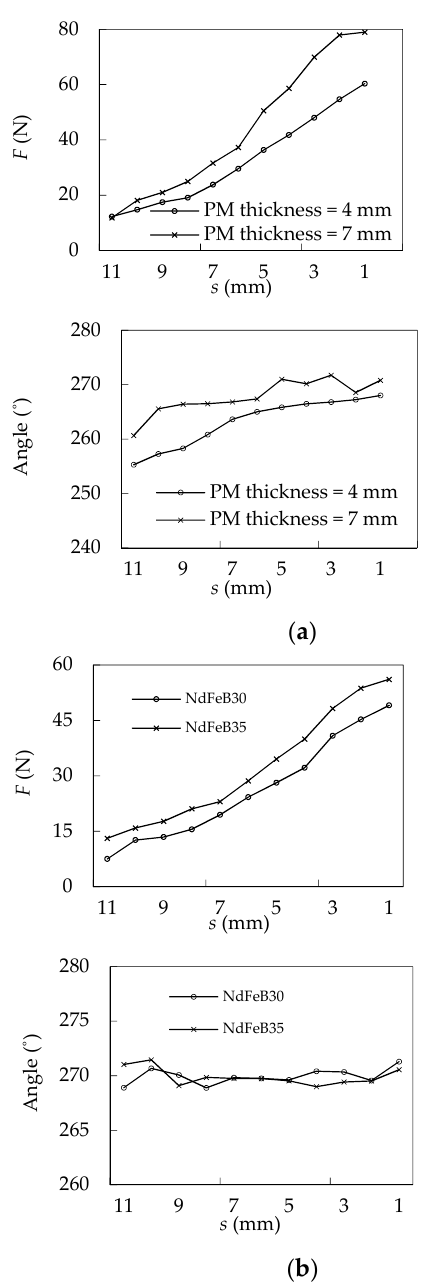
Figure 11. The effect of the PM thickness and material on EF: ( a ) the PM thickness (in the non- centerline, ratio = 2, L = 0.03 mm); ( b ) the PM material (in the non-centerline, L = 0.05 mm).